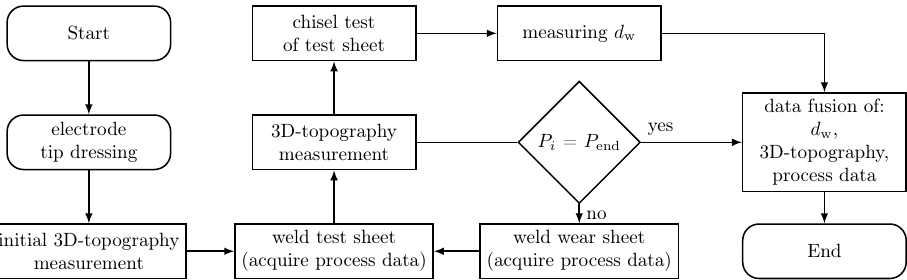
Figure 5. Test sequence of step tests with number of welded spot welds P i , number of spot weld to be welded P end for appropriate MC, and weld diameter d w .